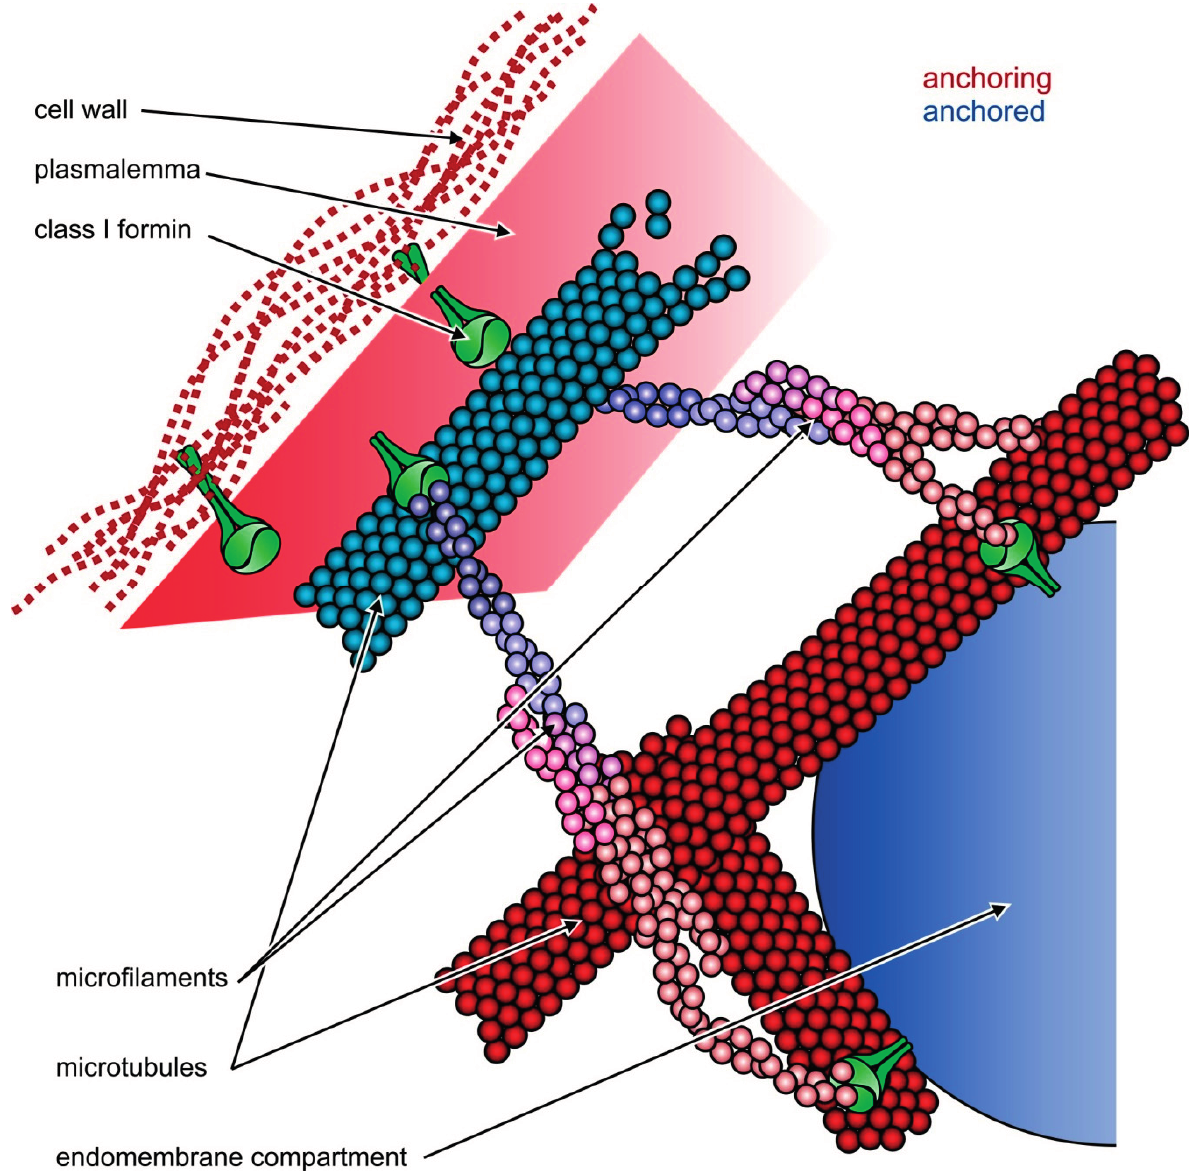
Figure 1. Possible roles of Class I plant formins such as AtFH8 (shown in green) in the organization of cytoskeletal and membrane structures. Relatively static structures shown in shades of red serve as a “dock” for anchoring more dynamic ones shown in blue. Top : formins can attach both microfilaments and microtubules to the plasmalemma, which is linked to the cell wall through integral membrane proteins, including the formins themselves (modified from [45]); Bottom : attachment of endomembrane compartments, such as the ER or secretory vesicles, to the cytoskeleton may be mediated by formins. While Class II formins cannot anchor the plasmalemma to the cell wall, they may also participate in endomembrane-cytoskeleton interactions as long as they bind to the membrane itself or to some integral or peripheral membrane